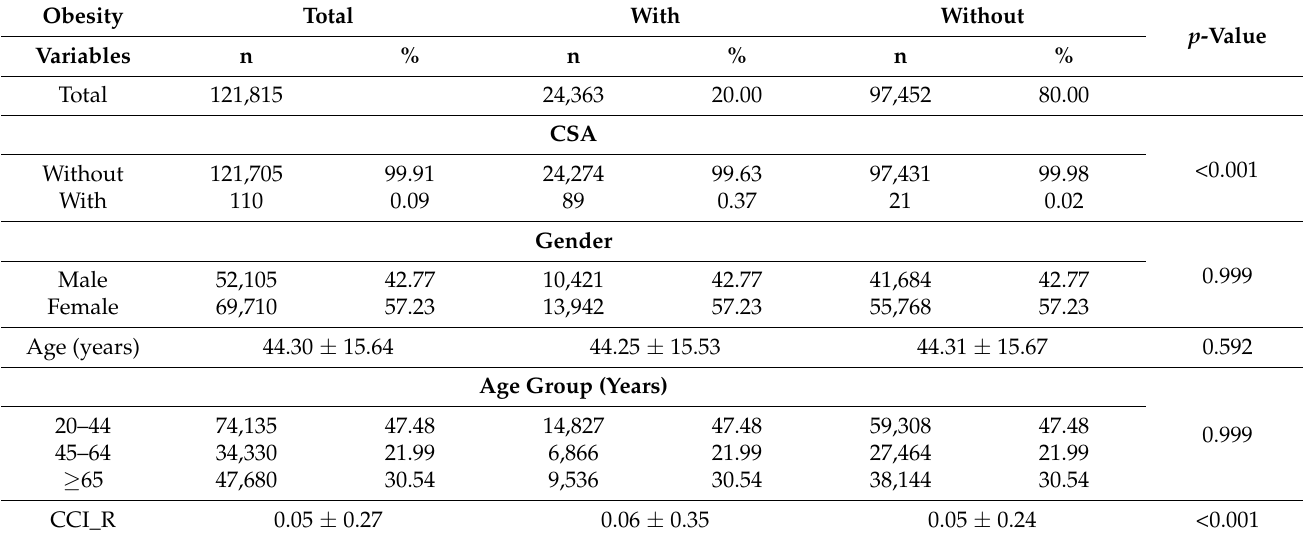
Table 1. Characteristics of the